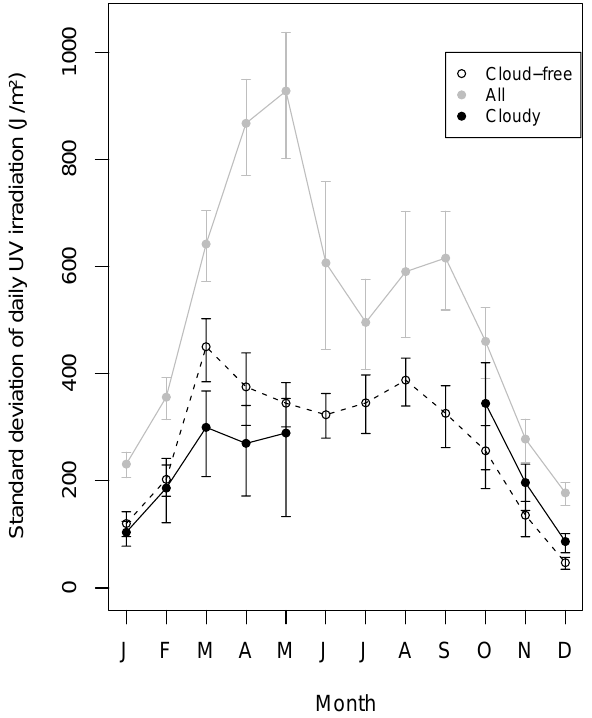
Annual evolution of the standard deviation of daily ultraviolet erythemal